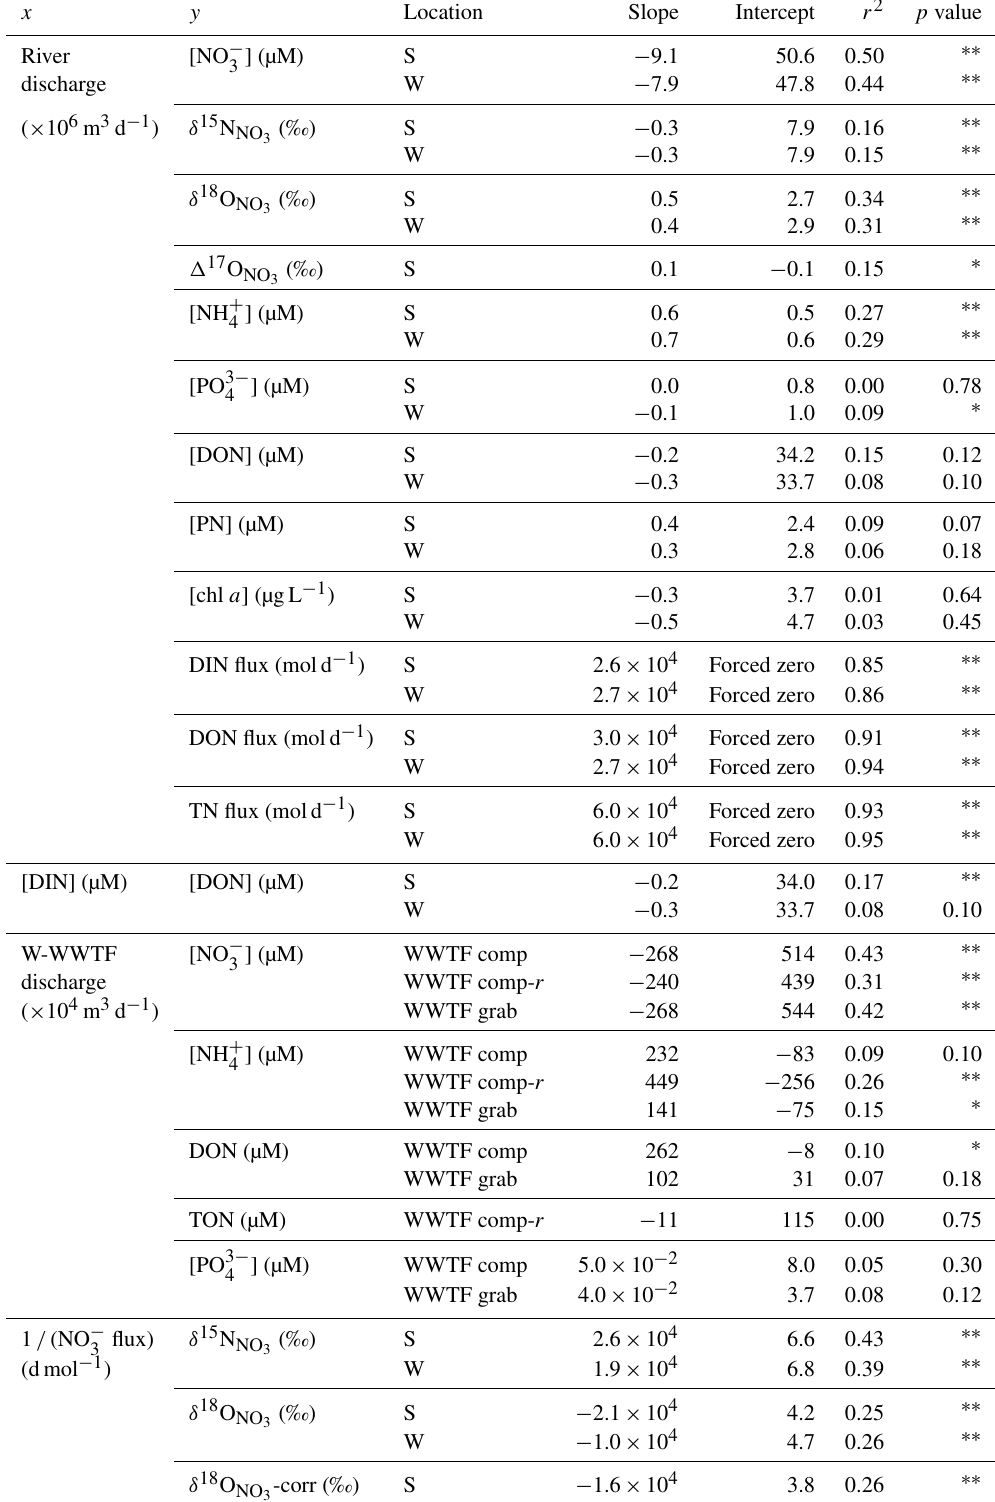
Table 1. Correlation coefficients, corresponding intercepts, coefficients of determination ( r 2 ), and statistical probability of least-squared regression analyses from property–property plots of riverine solutes and fluxes. Statistically significant relationships are signaled by an asterisk ( p value ≤ 0 . 05 ∗ ; ≤ 0 . 01 ∗∗